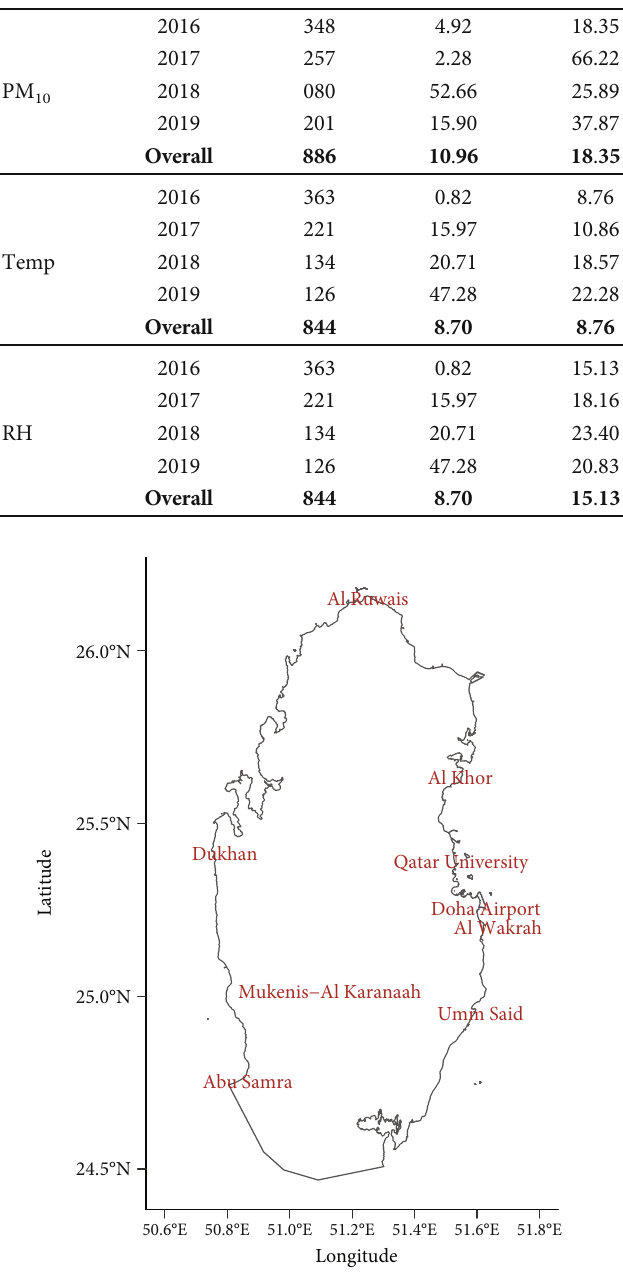
Figure 1: A map of the state of Qatar showing locations of the 9 monitoring sites.